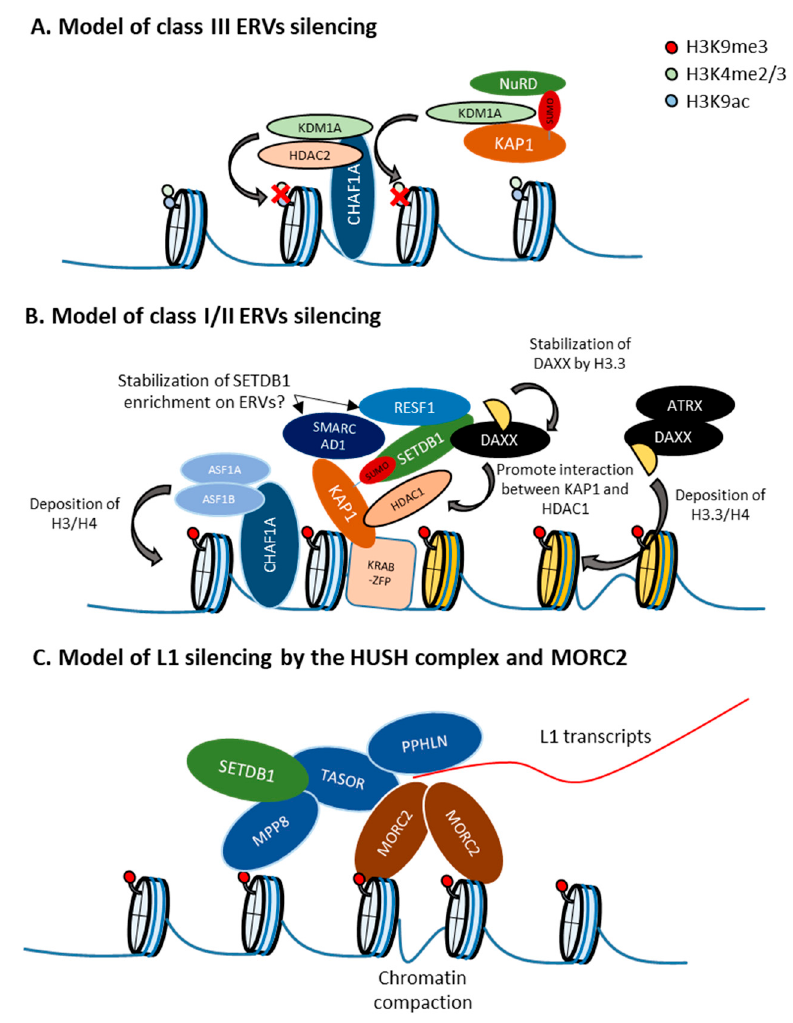
Figure 3. Retroelement-type specific regulation. ( A ) Model of class III endogenous retroviruses